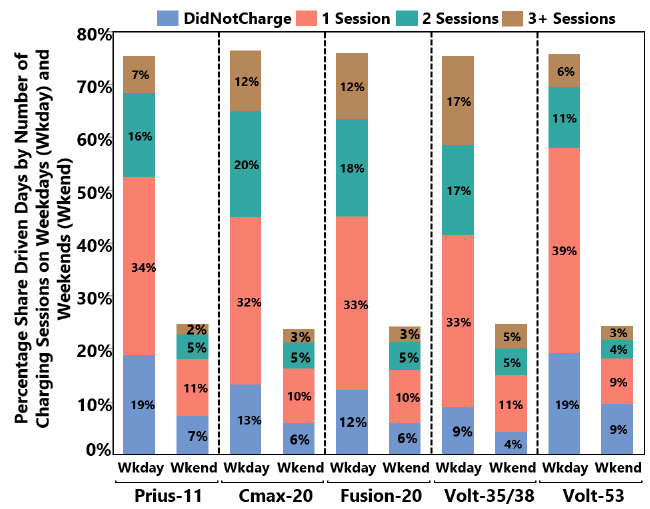
Figure 8. Percentage share of driven days by number of charging sessions on weekdays and weekends.